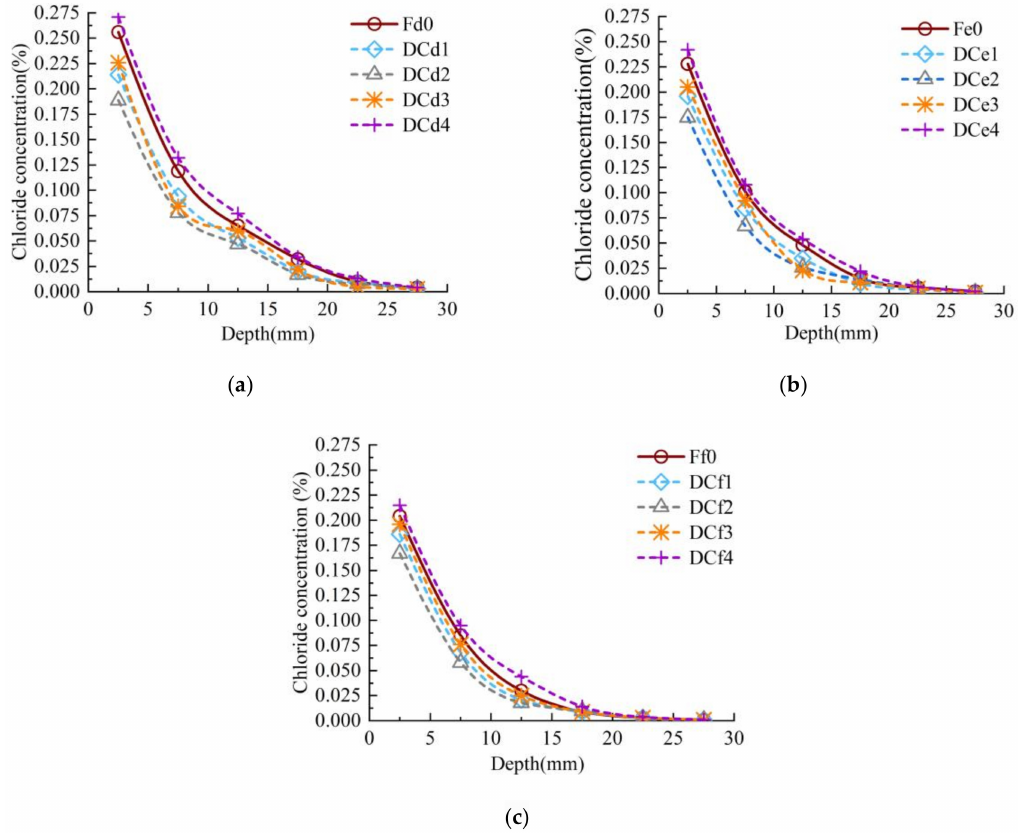
Figure 3. Chloride concentration distribution of concrete with three w / c ratios under uniaxial sustained stress: ( a ) w / c = 0.44; ( b ) w / c = 0.4; ( c ) w / c = 0.36.